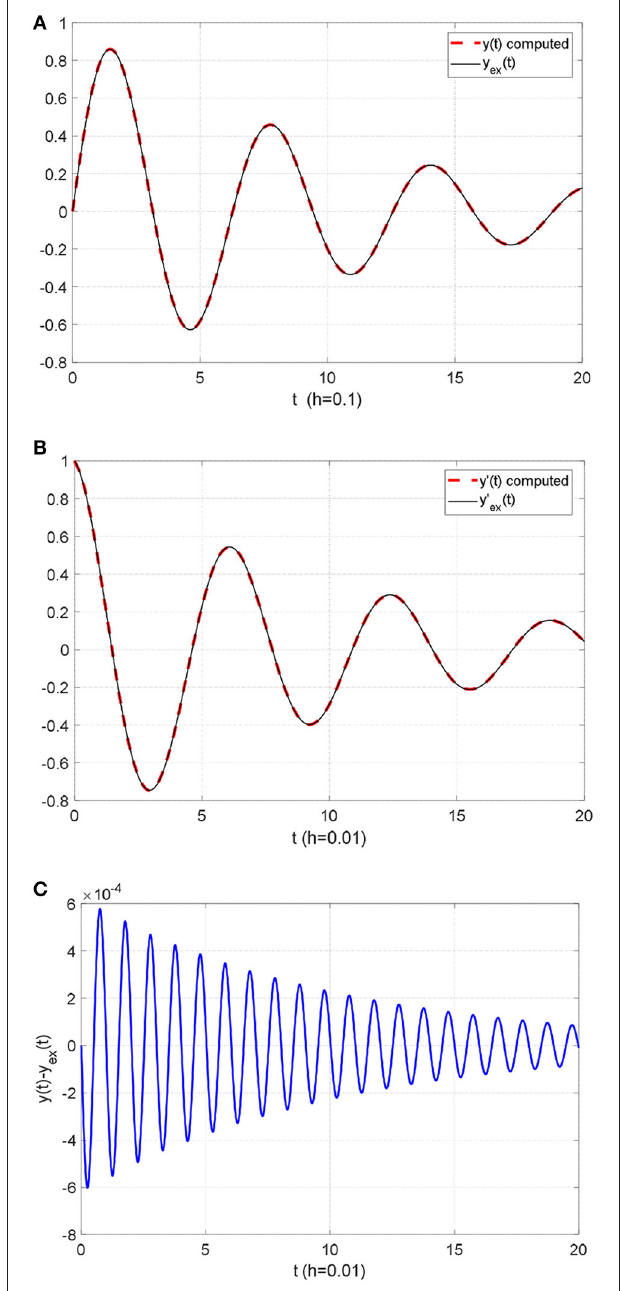
FIGURE 8 | (A) Solution y ( t ) in Example 8. (B) Derivative y ′ ( t ) of the solution in y ex in Example Example 8. (C) Error y −